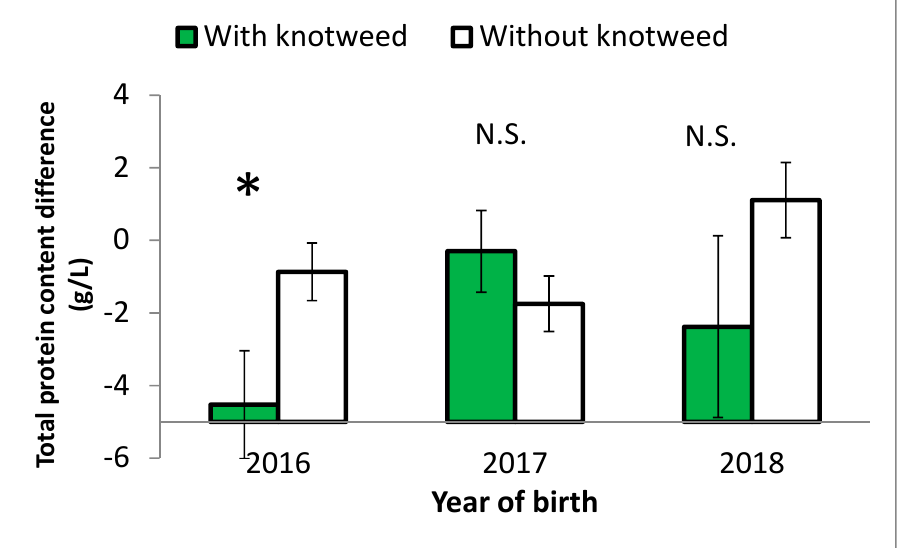
Figure 2. Differences in the total protein content in equine blood between the beginning and the end of Experiment 2, shown for stallions of the three age groups (born in 2016, 2017 and 2018) fed and not fed knotweed. Means ± SEM. Statistically different values at p ≤ 0.05 are marked with *. N.S. = non-significant difference.